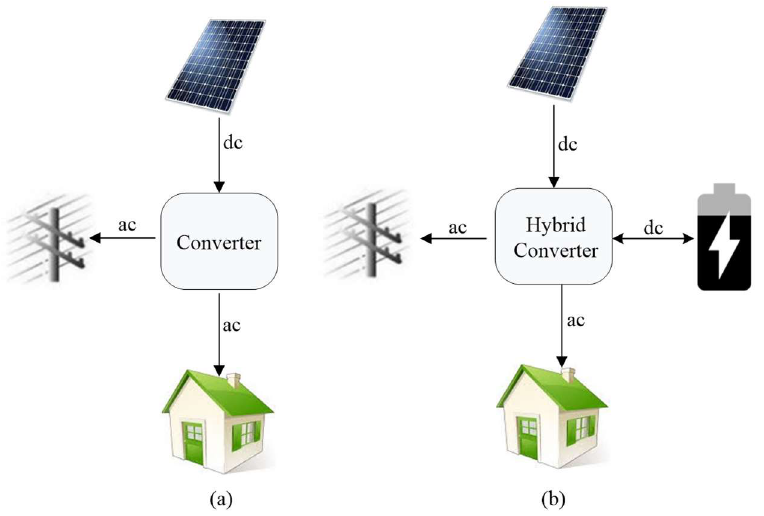
Figure 1. Schematic diagram of a solar energy system: without ( a ) and with ( b ) battery storage assistance.